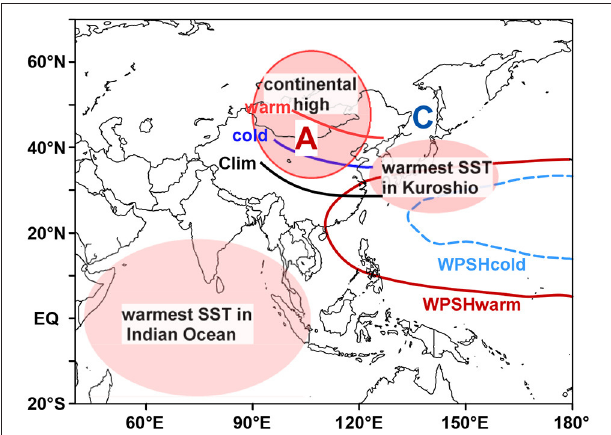
FIGURE 11 | Sketch map of North China’s possible EWES causes. The dashed blue line (WPSH cold) and solid red line (WPSH warm) represent WPSH position during extremely warm years in the warm and cold periods, respectively. The thick lines (marked as warm, cold, and clim) mean the southern boundaries (the zero-vorticity line) of NECV with the red (blue) line extremely warm years for warm (cold) period and black line for climatological state. Letters A and C correspondingly mean the low-level anomalies of the anticyclone and cyclone.